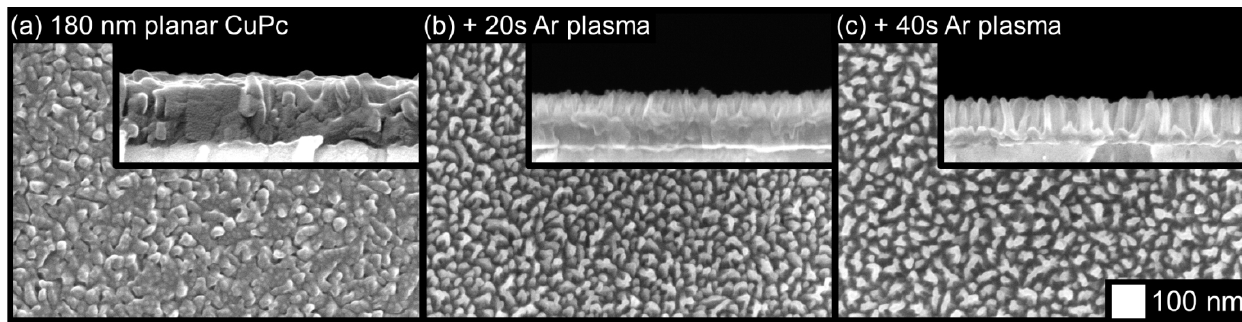
Figure 1. Effects of argon plasma etching on a planar CuPc thin film.